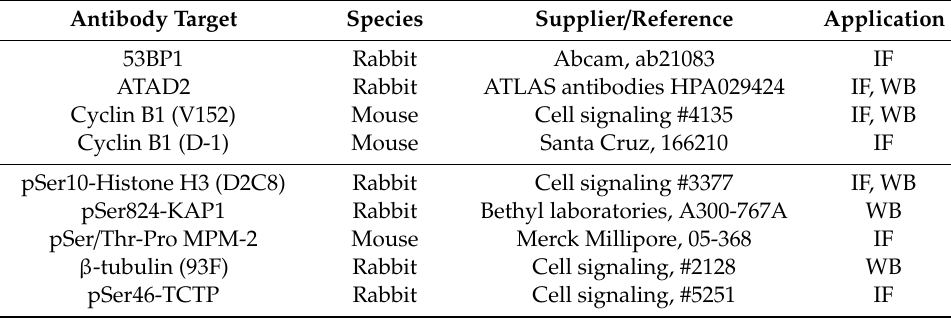
Table 1. Information on antibodies used in this